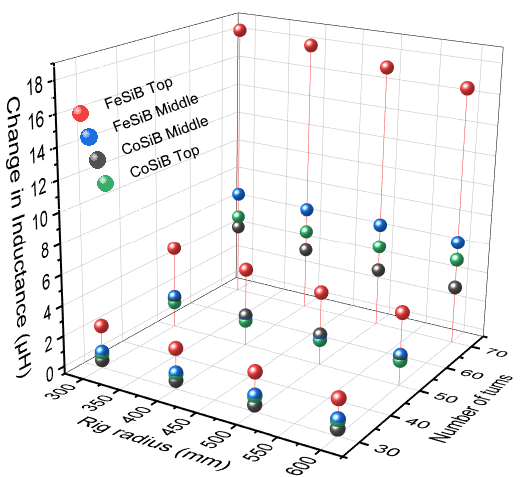
Figure 11. Change in inductance vs number of turns vs rig radius using different actuator